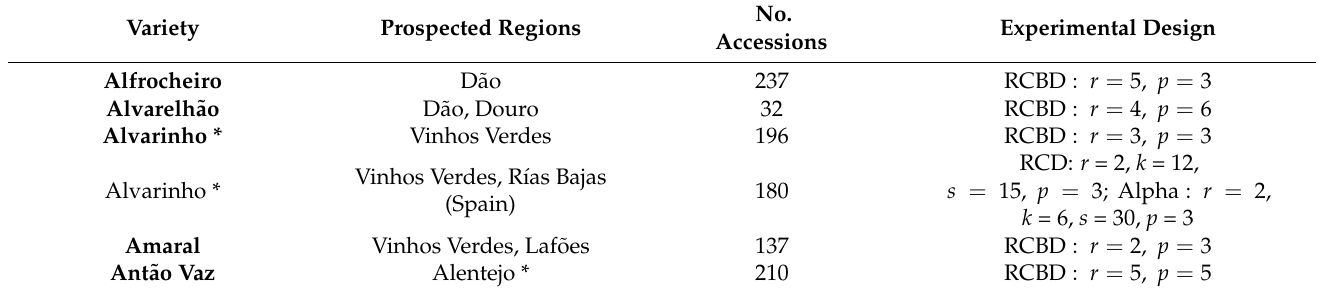
Table 2. Conservation in fully replicated field trials of 63 varieties in Portugal for evaluation of intra- varietal diversity and polyclonal selection (CRD, complete randomized design; RCBD, randomized complete block design; RCD, resolvable row-column design; Alpha, Alpha design; ν , number of genotypes; r, number of complete blocks; k, number of rows nested within complete block; s, number of columns nested within a complete block; p, plants per experimental unit (plot)). The yield data collected in the field trials highlighted in bold were used to evaluate the intra-varietal diversity